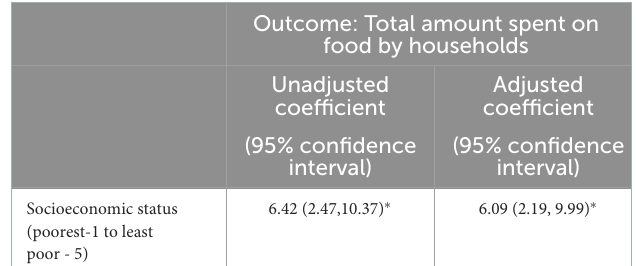
TABLE 7 Association of household socioeconomic status with expenditure on food in Western Region,